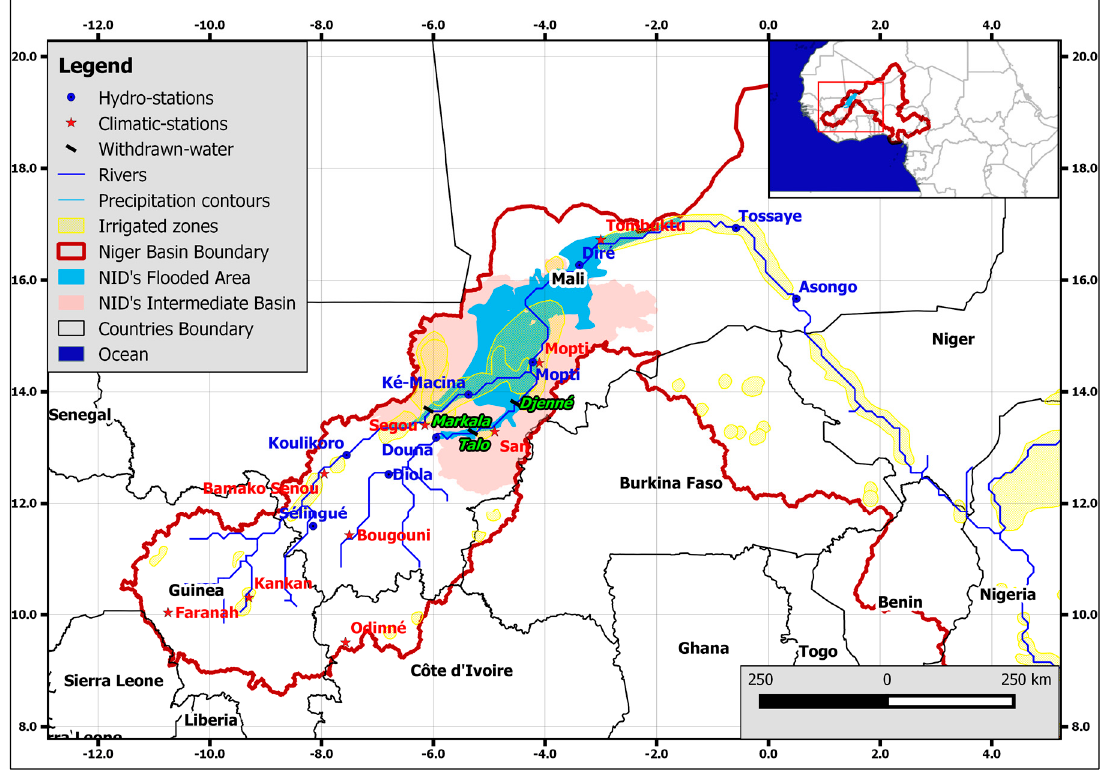
Figure 1. Location of the Niger Inland Delta (NID) within the Niger River basin and hydro-meteorological stations.